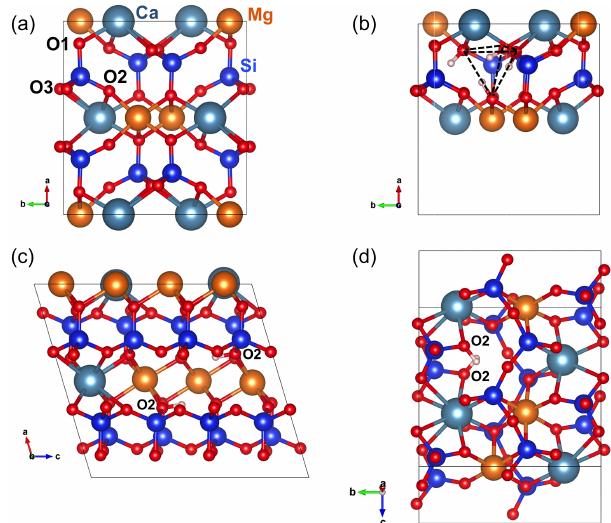
Figure 2. (a) Structure of diopside viewed along the [001] direction. (b) Structure of the (4H + ) × defect in diopside viewed along the Si [001] direction (model 1, Table 1). (c) Structure of the (2H + ) × de- M2 fect in diopside viewed along the [010] direction (model 2, Table 1). Note the two O2–H groups lying in the (001) plane. (d) Structure of the (2H + ) × defect in diopside viewed along the [100] direc- M1 tion (model 4, Table 1). Atom colors – Si: blue; oxygen: red; Mg: orange; Ca: greyish blue; H: light